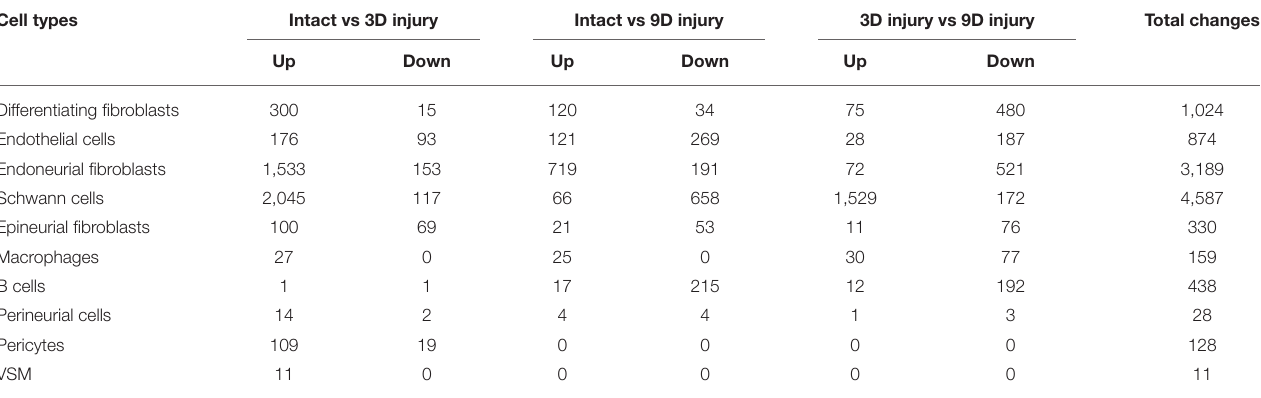
TABLE 1 | Cell type specific gene up- and